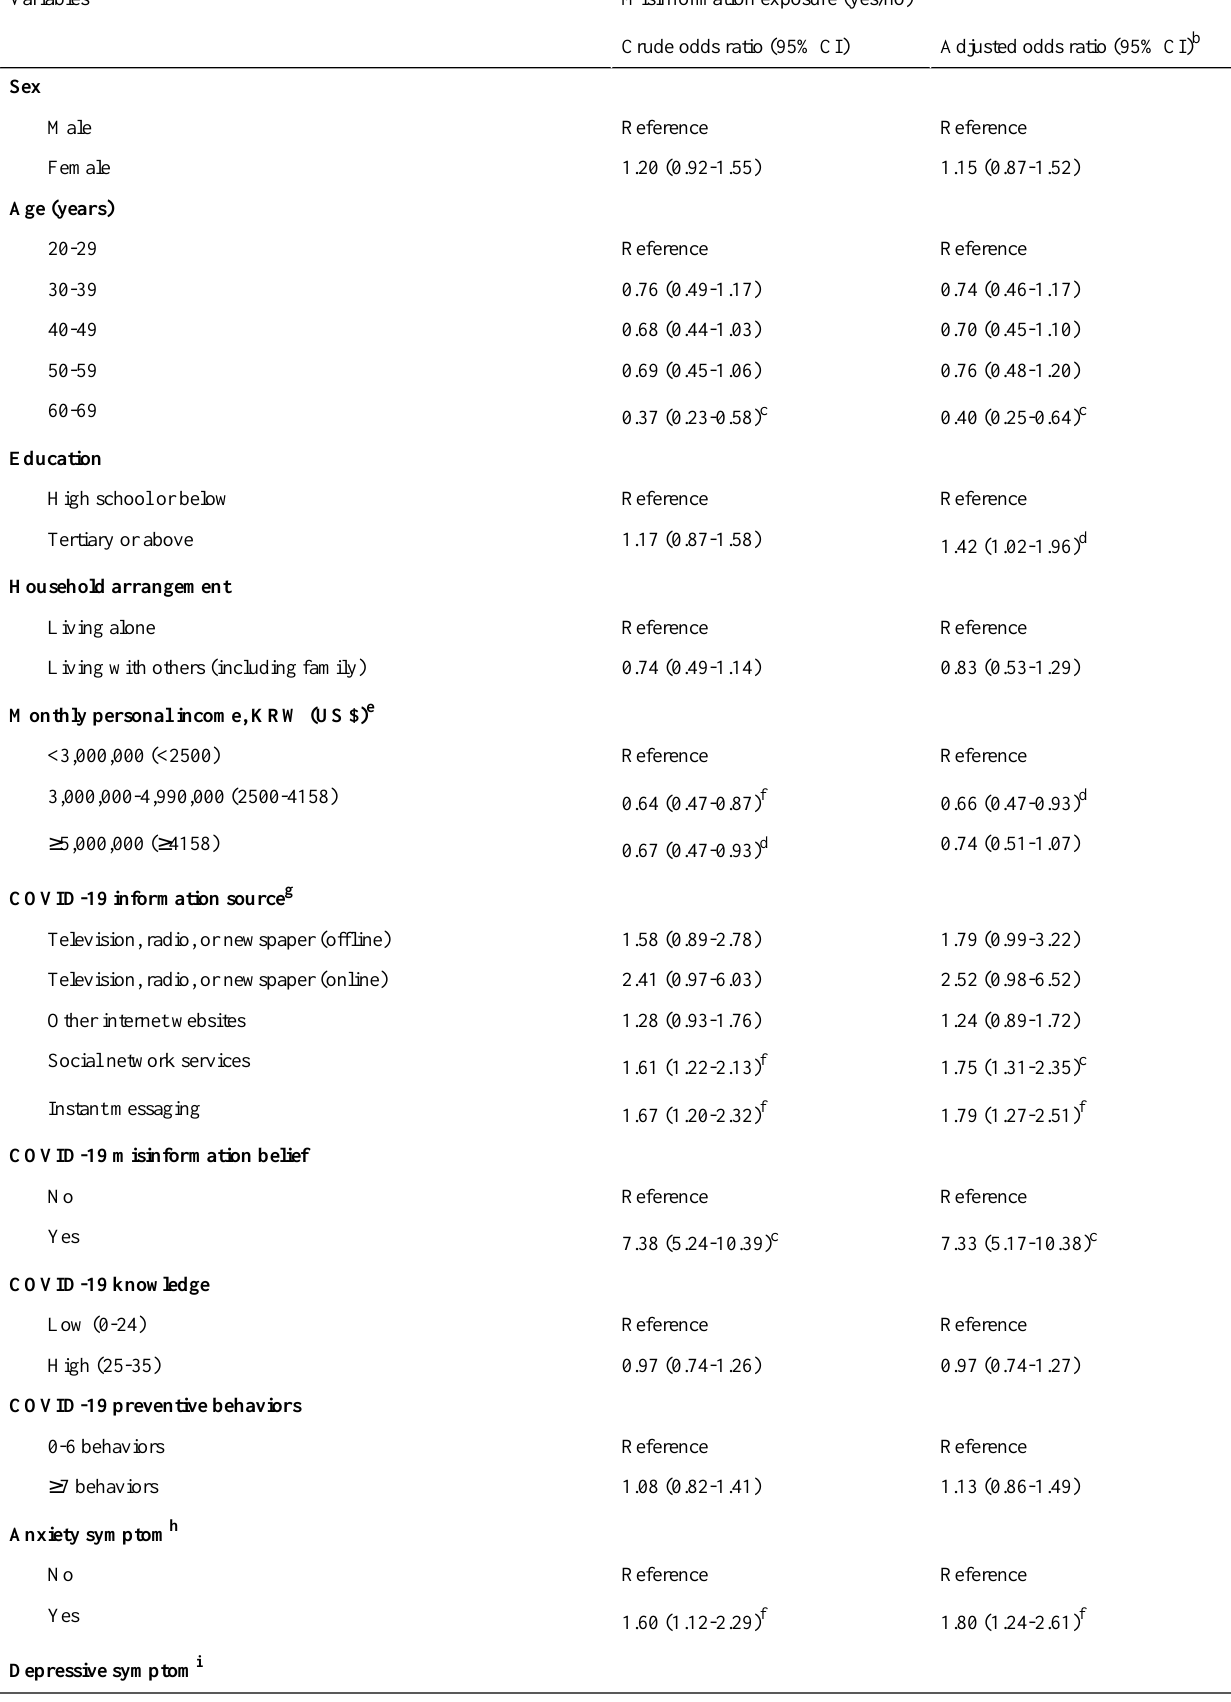
Misinformation exposure